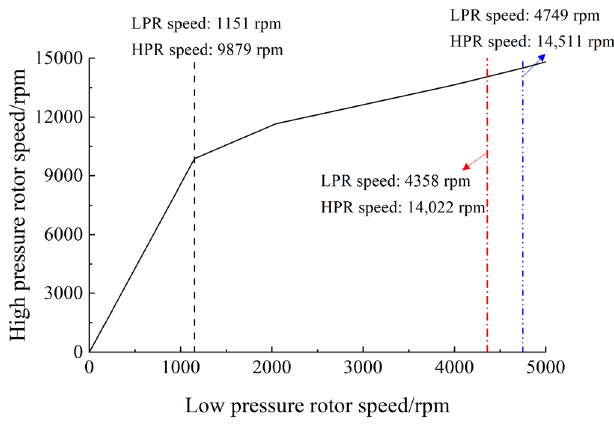
Figure 6. High- and low-pressure rotor common working line.